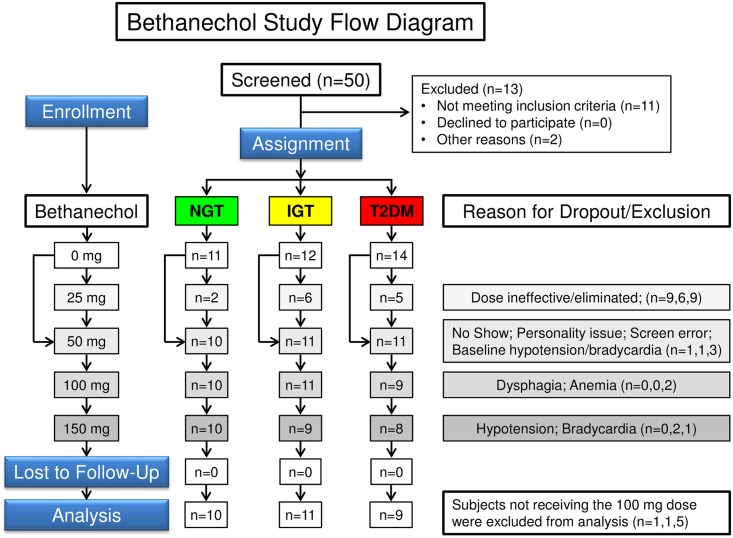
Flow diagram for bethanechol study.Diagram is for a non-randomized crossover study with escalating doses of bethanechol in humans with NGT, IGT, and T2DM.